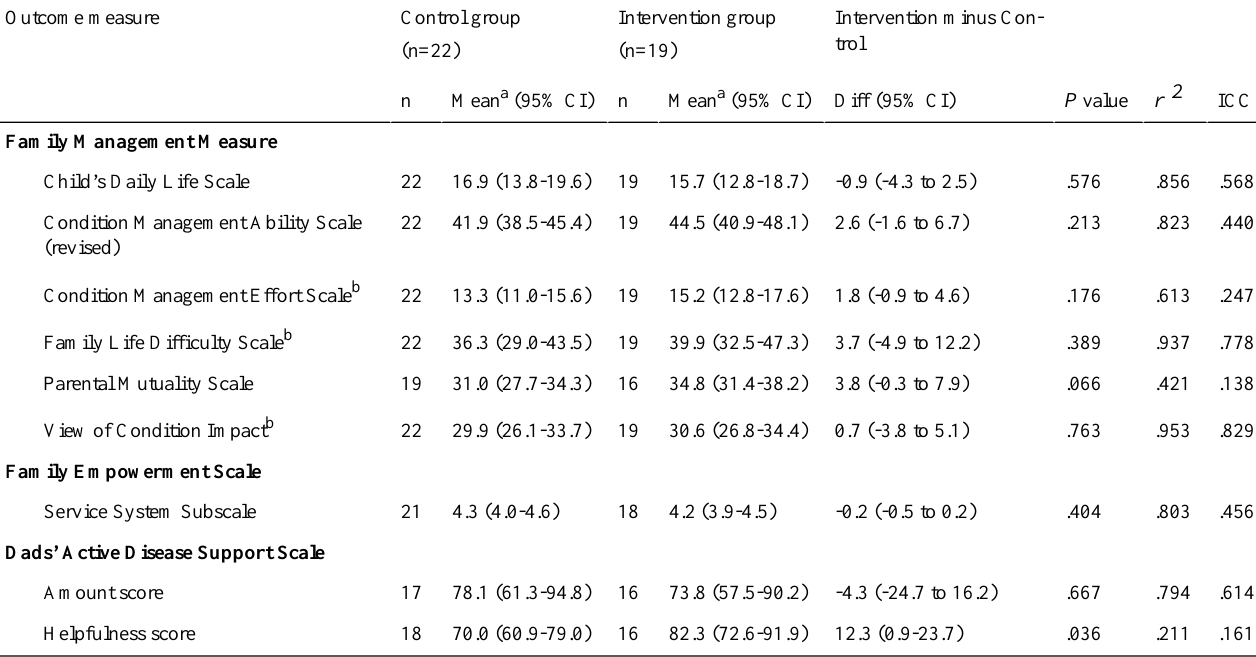
Table 5. Estimated marginal means a for outcome scores by randomized group and their differences at end trial using linear mixed model.